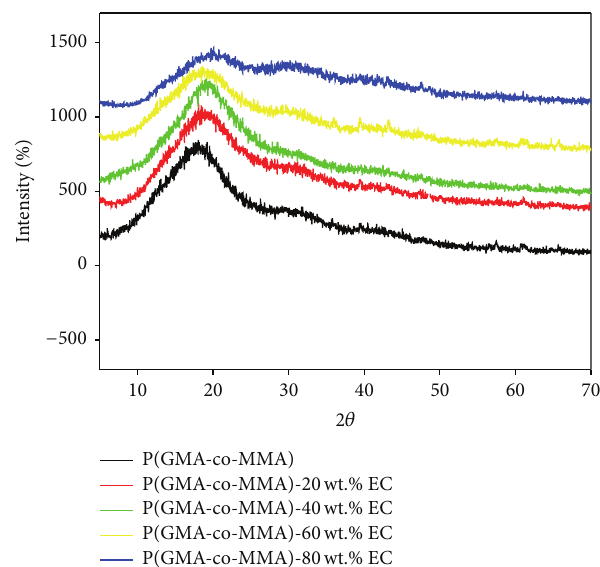
Figure 8: XRD patterns of P(GMA-co-MMA) 25 wt.% LiClO 4 as a function of EC content.